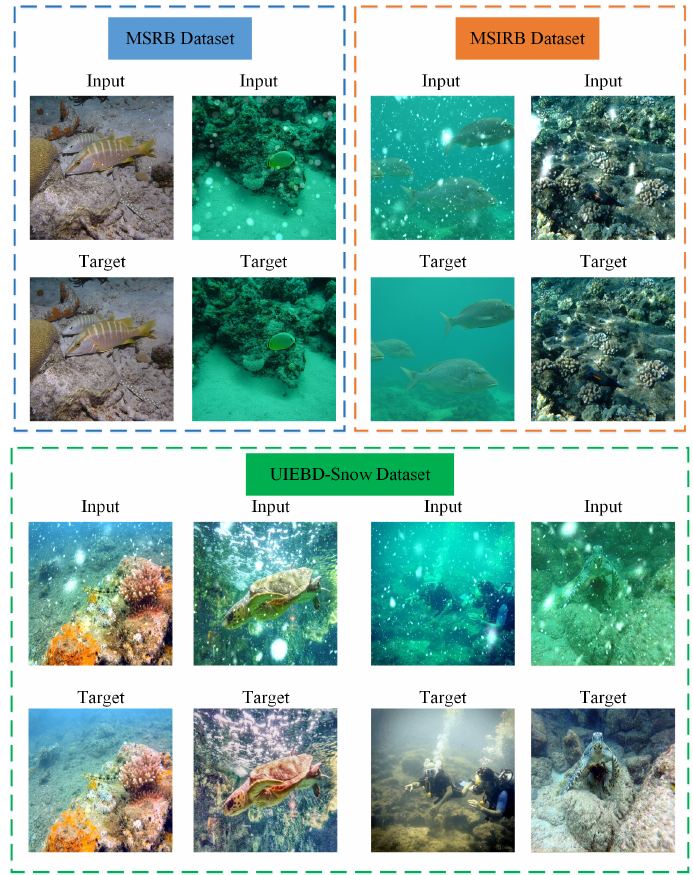
Figure 4. Examples from MSRB, MSIRB and